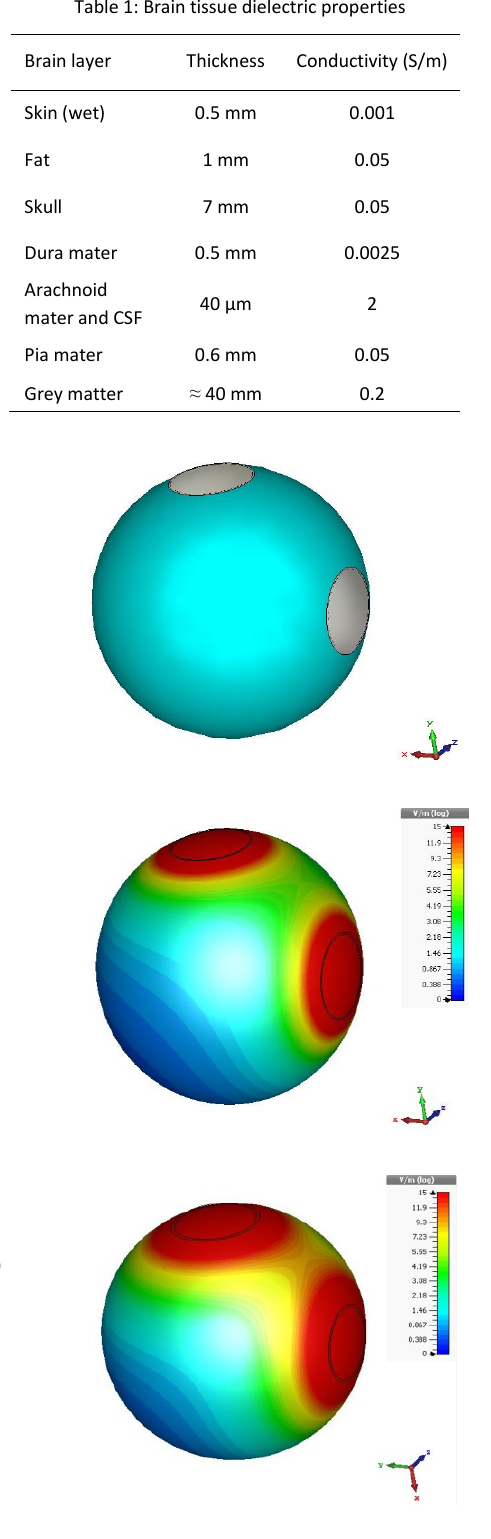
Fig. 4: Geometry of electrodes on human head (a), and electric field distribution in the head model without and with considering meninges while injected current equal to 2 mA (b and c).